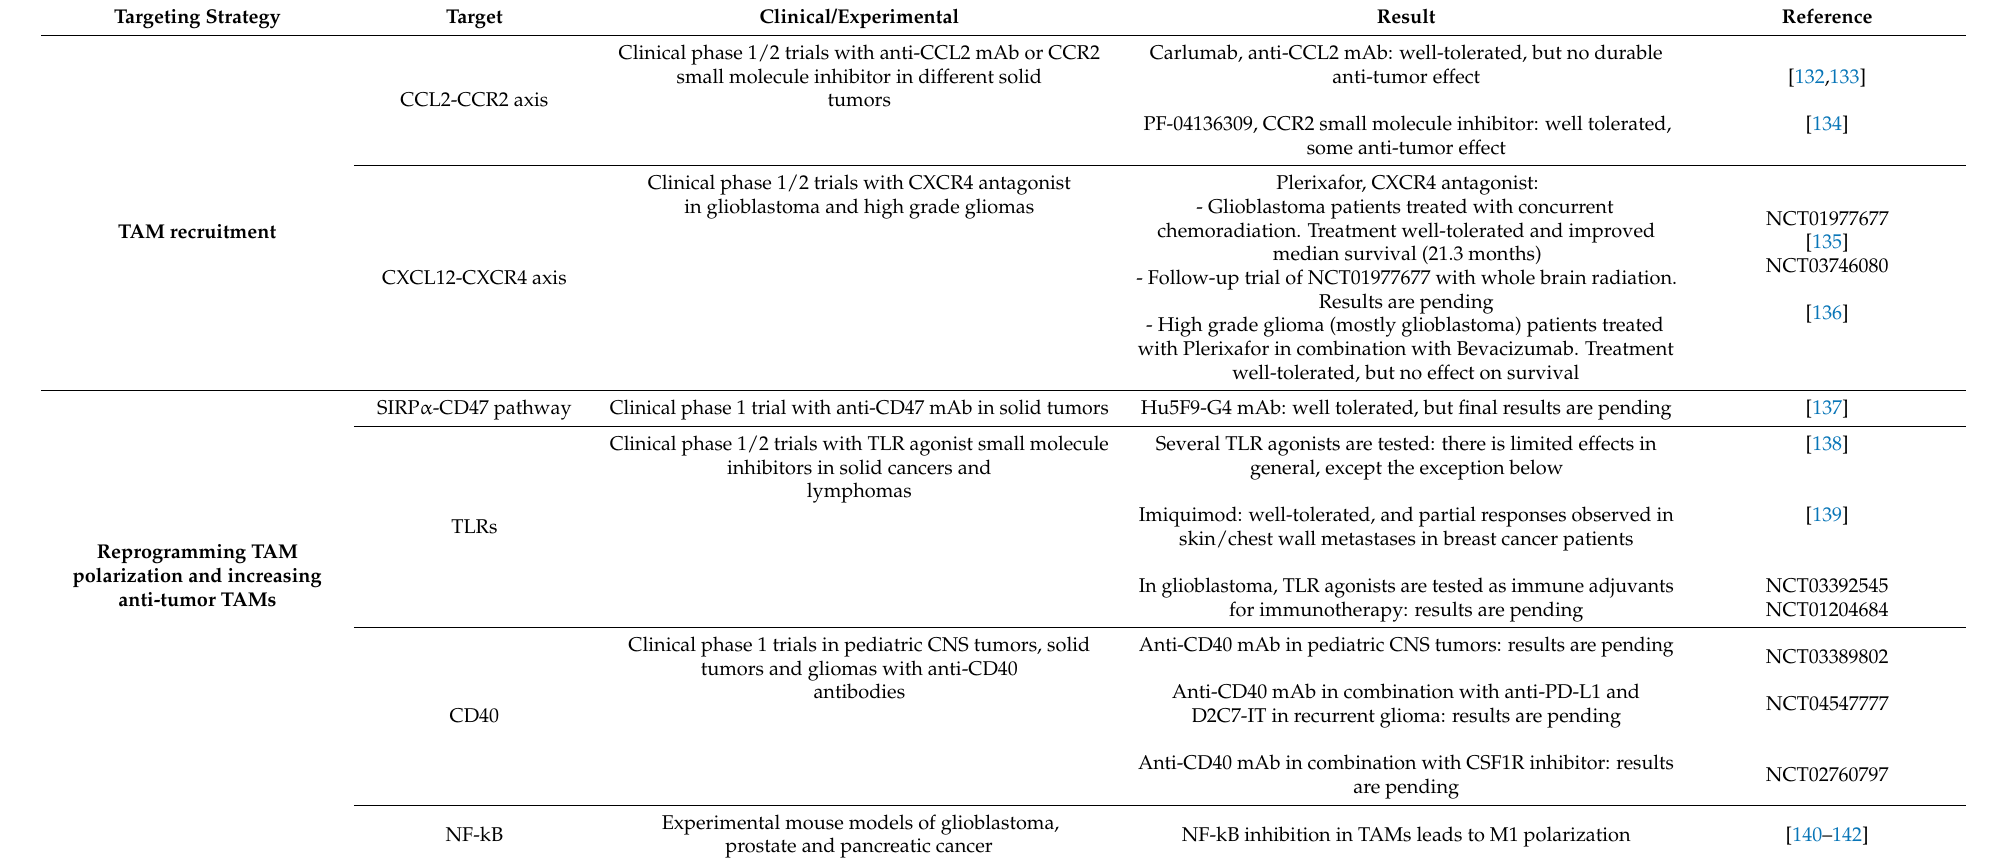
Table 1. Overview of selected clinical and experimental strategies targeting